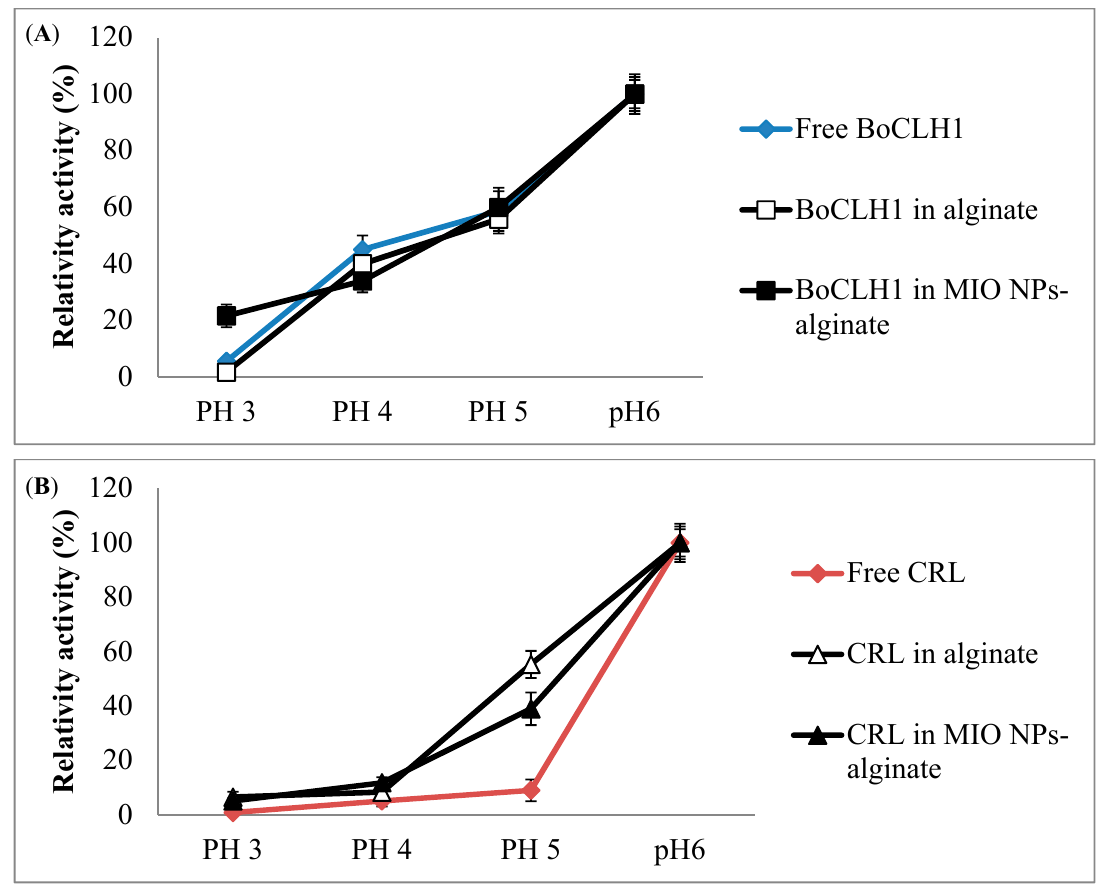
Figure 5. The pH effects on the activity of immobilized BoCLH1 and CRL activity. ( A ) The pH activity of free BoCLH1 ( ◆ ), BoCLH1 in alginate ( □ ) and BoCLH1 in MIO NPs-alginate ( ■ ) indicated, respectively. ( B ) The pH activity of free CRL ( ◆ ), CEL in alginate ( (cid:4574) ) and CRL in MIO NPs-alginate ( ▲ ) indicated, respectively. The Chlase and esterase assay using Chl a and p -nitrophenol butyrate as substrate respectively. Relative activity (%) was triplicate measured according to the standard Chlase and esterase